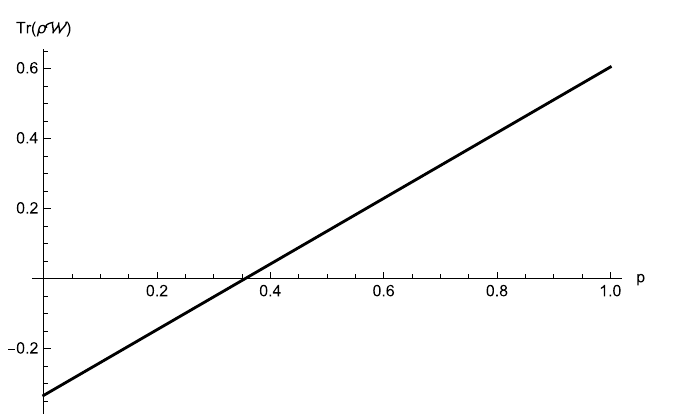
Figure 3. For the four-partite Dicke state D 4 2 mixed with the white noise ρ 2 . The the blue line stands for F and the red dash line stands for F we can see that the state ρ 2 violates one of the inequalities (4), whence our criterion detects the entanglement of 0.543 . ρ 2 for 0 p ≤ ≤